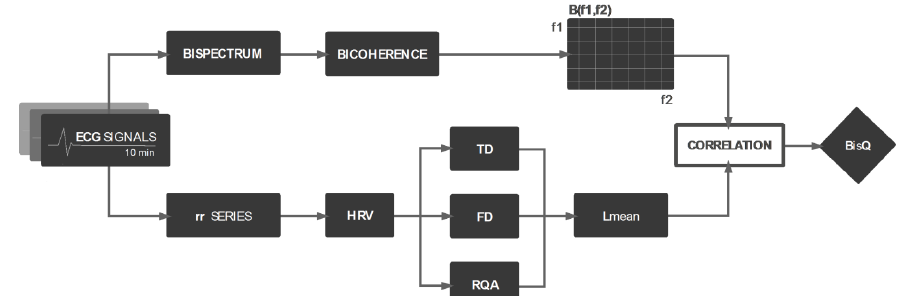
Figure 1. Flow chart for the creation of the bispectral measure BisQ. TD, FD, and RQA stand for extraction of Time Domain, Frequency Domain, and Recurrent Quantification Analysis features, respectively; B(f1,f2) represents the bicoherence matrix.